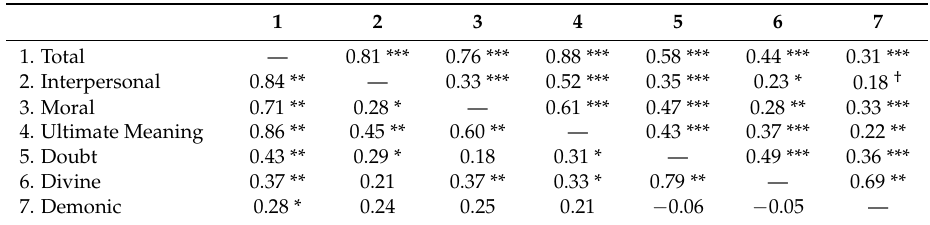
Table 3. Correlations among RSS Subscales.